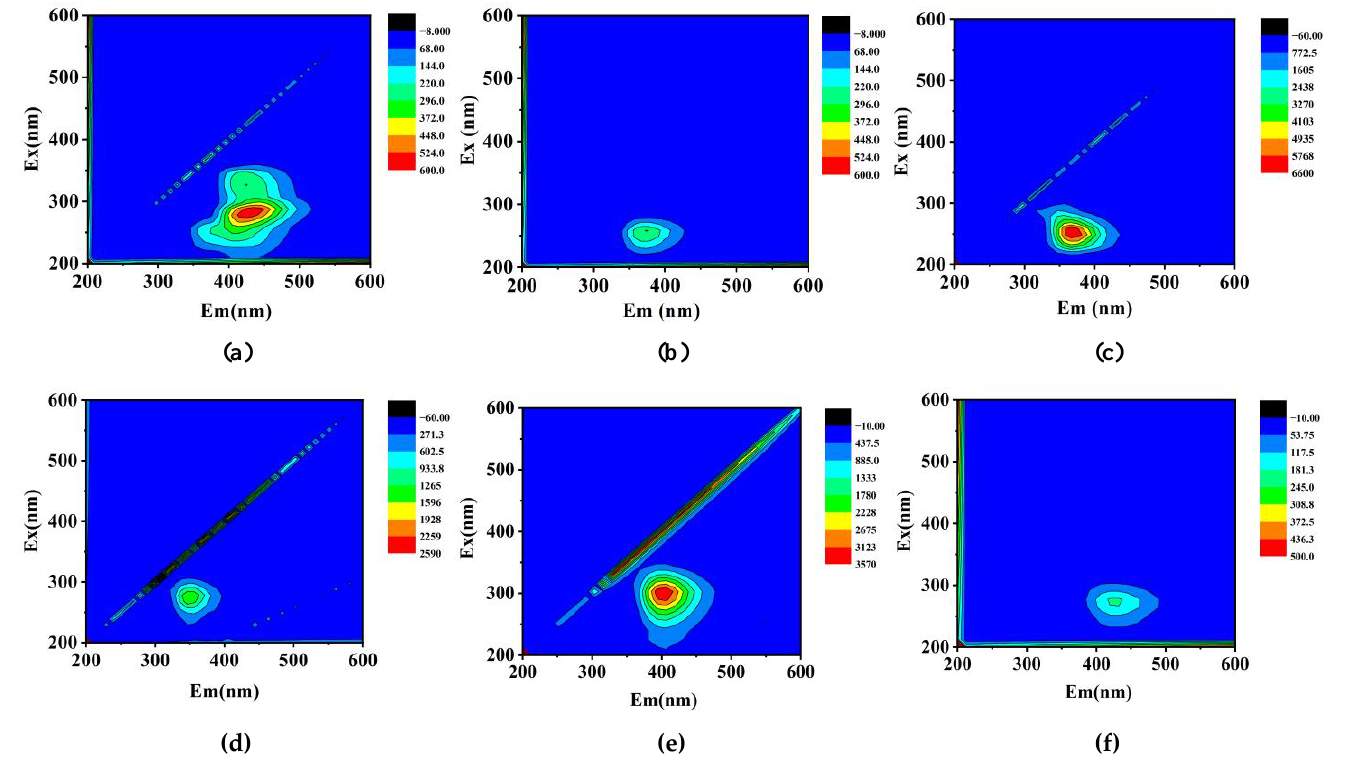
Figure 10. Three-dimensional EEMs images of ( a,b ) NOR and ( c , d ) SMX after visible light irradiation 0, 120 min; and ( e , f ) TCH solutions after visible light irradiation 0, 60 min.